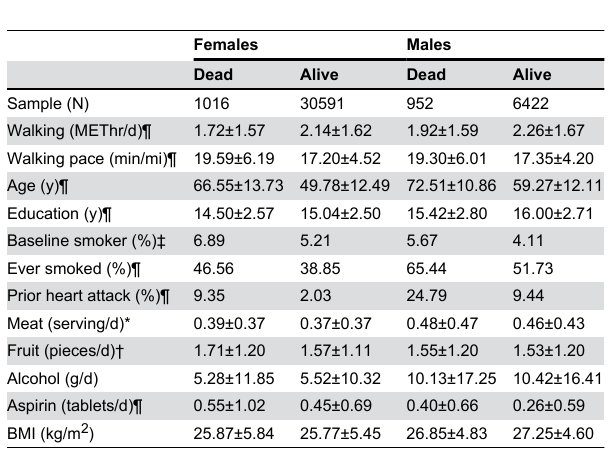
Table 2. Sample characteristics (mean±SD) by mortality status.